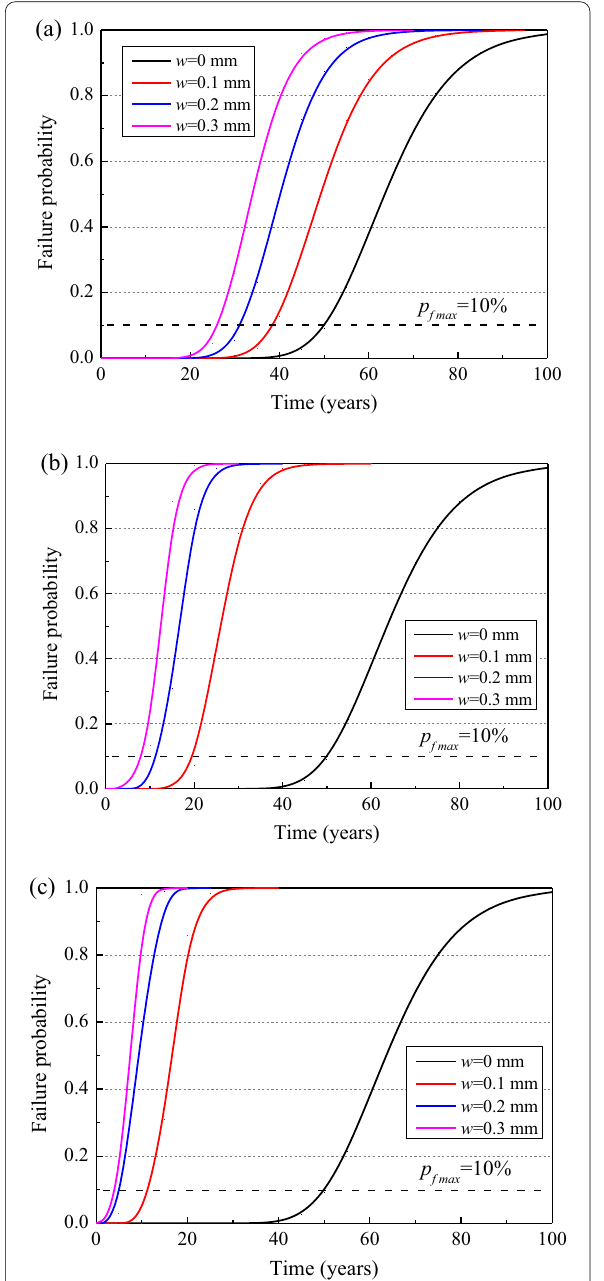
Fig. 5 Variations of failure probabilities with exposure time for different number of cracks: a n